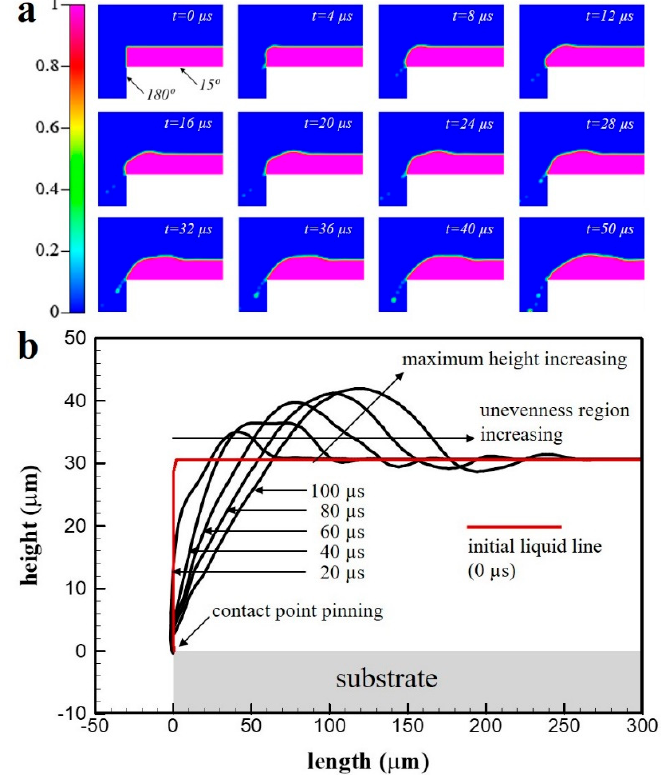
Figure 6. ( a ) Coating fluid behavior over time at the edge of the substrate under a substrate surface contact angle of 15° and a side contact angle of 180°. ( b ) Surface profile under different wetting conditions. wetting